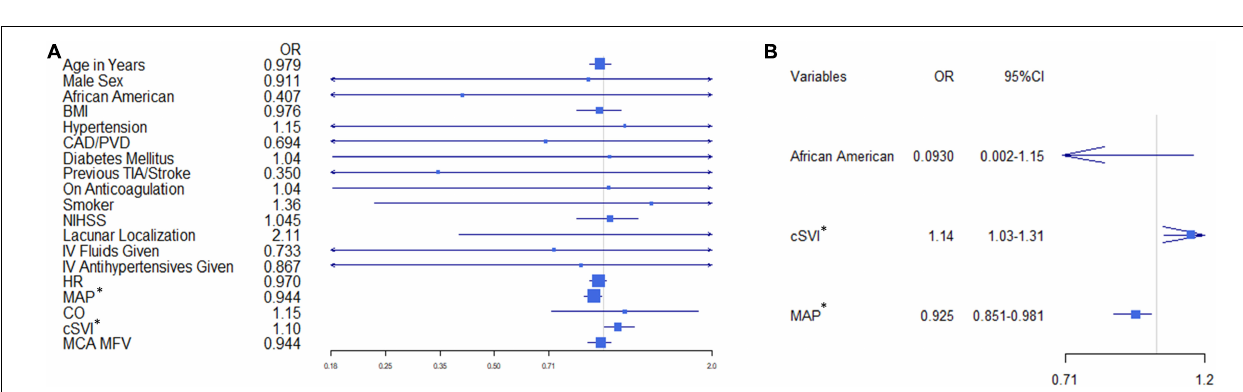
0.093; 95% CI 0.002–1.15, P = 0.112, Table 1B and Figure 2B ). Pseudo-R 2 for African American race, MAP and cSVI were 0.0195, 0.168, 0.133, while cumulative pseudo-R 2 was